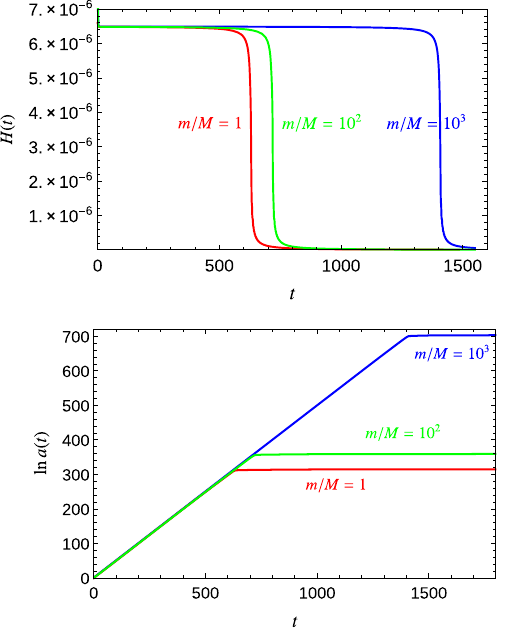
Fig. 8 Top:theHubbleparameterasafunctionoftimeforthevaluesof the ratio m / M = 1 , 10 2 , 10 3 . Bottom: the logarithm of the scale factor a ( t ) as a function of time for the values of the ratio m / M = 1 , 10 2 , 10